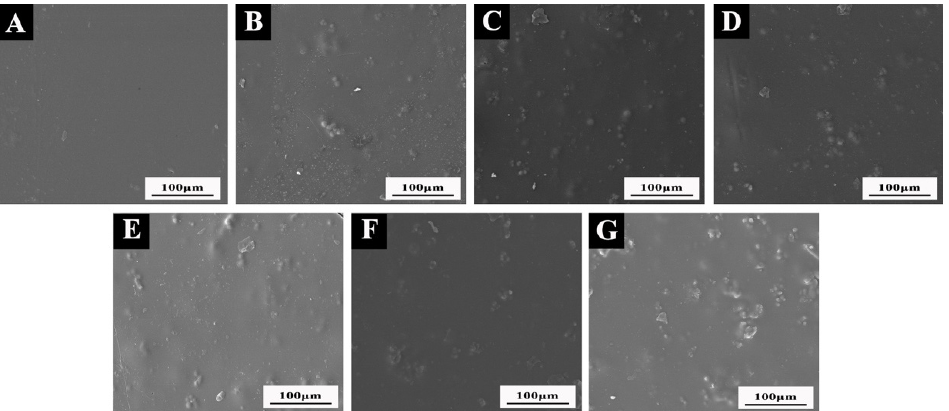
Figure 5. SEM of coatings with ( A ) 0 microcapsules; ( B ) 3.0 wt.% transparent shellac microcapsules; ( C ) 6.0 wt.% transparent shellac microcapsules; ( D ) 3.0 wt.% purple shellac microcapsules; ( E ) 6.0 wt.% purple shellac microcapsules; ( F ) 3.0 wt.% yellow shellac microcapsules; ( G ) 6.0 wt.% yellow shellac microcapsules.